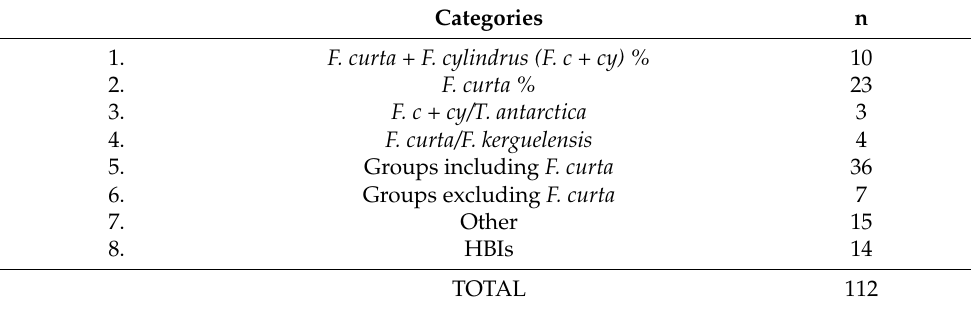
Table 3. Number of records for different proxy